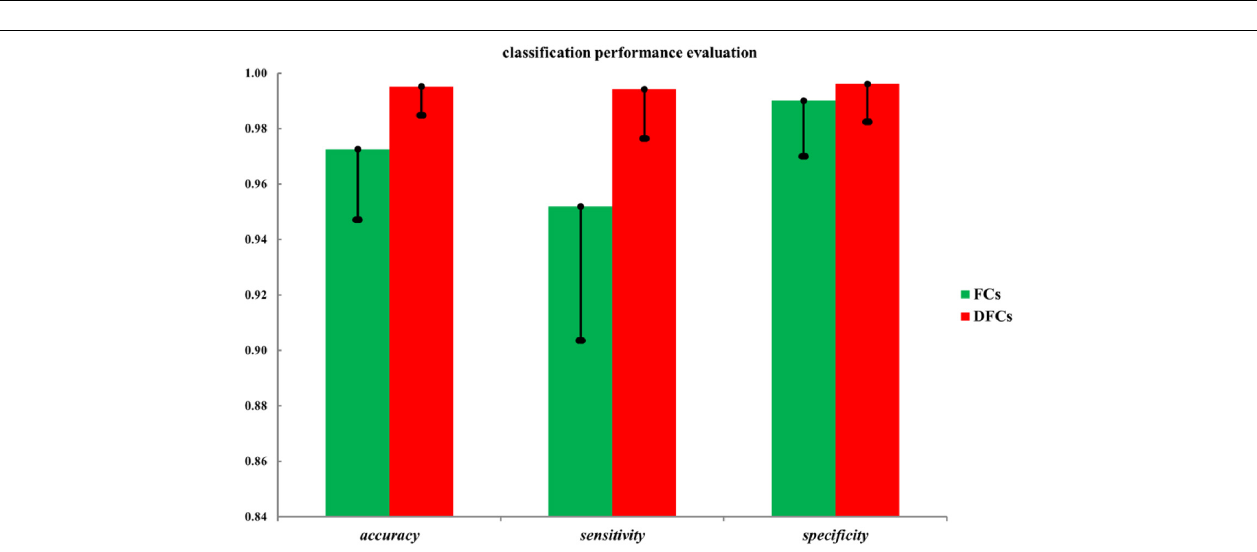
FIGURE 4 | The classification accuracy, sensitivity, and specificity using all functional connectivities (FCs) and FCs with significant differences (DFCs) between the common activated voxels of the seafarer and non-seafarer groups.